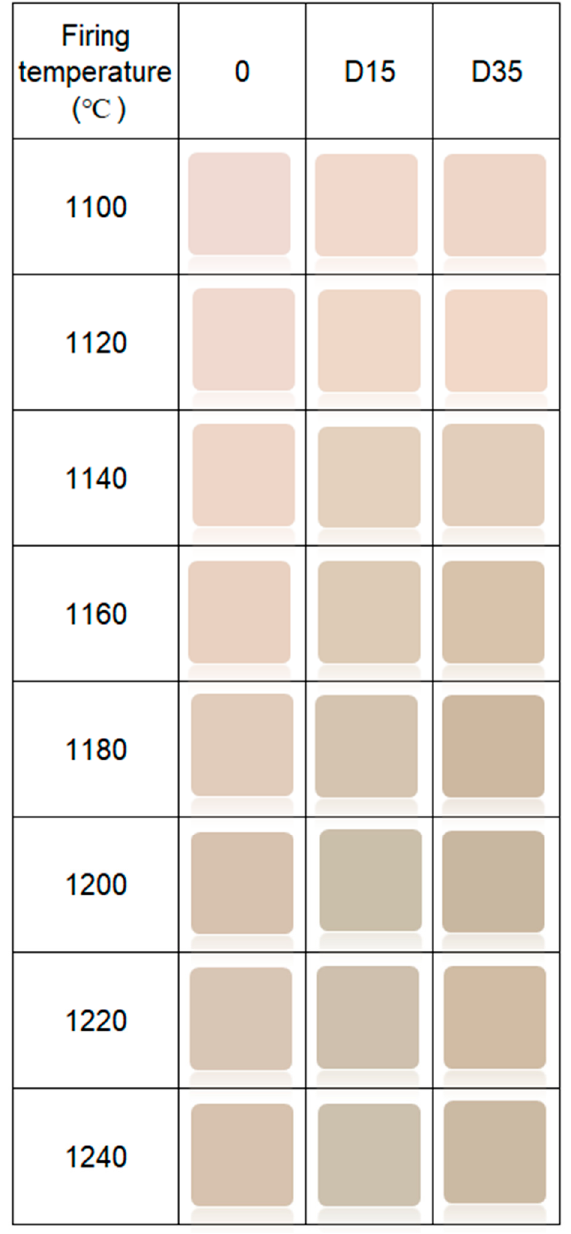
Figure 7. Color of surface of obtained ceramic materials.